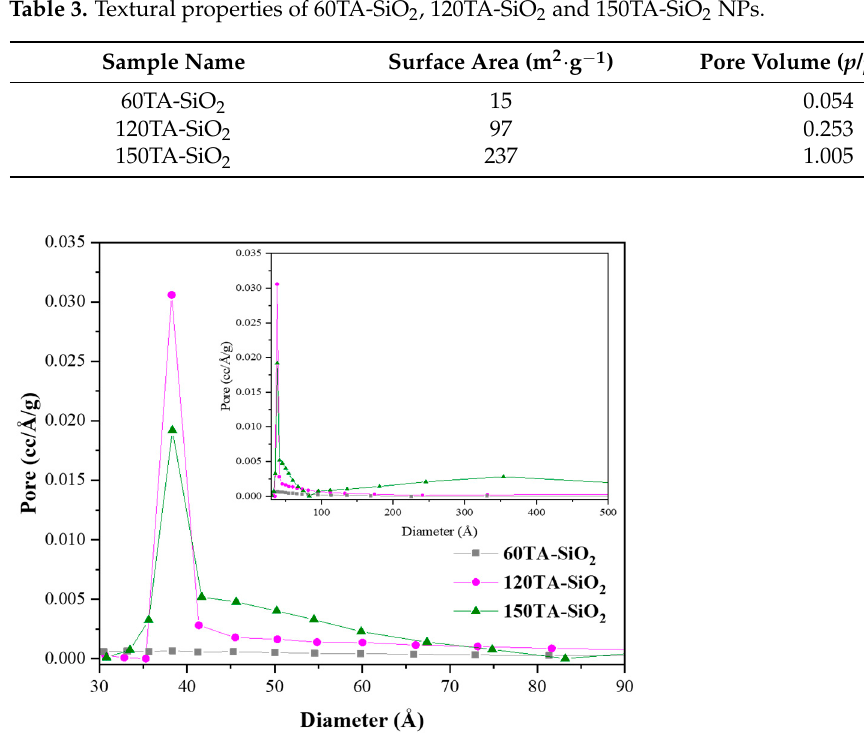
Figure 6. BJH pore size distribution plot derived from the desorption branch of the isotherm for: 60TA-SiO 2 , 120TA-SiO 2 and 150TA-SiO 2 NPs. Curves are reported in the small mesoporous range